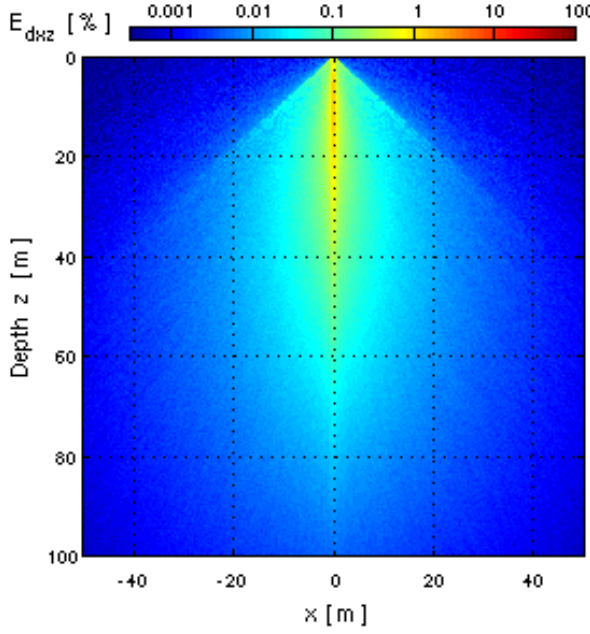
2 Fig. 1. Spatial expansion of light, in terms of the downwelling ir- Figure 1. Spatial expansion of light, in terms of the downwelling irradiance E radiance E d , within the water column due to 90% direct solar ir- radiation (zenith angle 0 ◦ ), 10% isotropic diffuse skylight and a the water column due to 90 % direct solar irradiation (zenith angle 0°), 10 % isotropic diffuse 4 non-tilted wave facet (logarithmic color skylight and an non-tilted wave facet (logarithmic color scale). 5